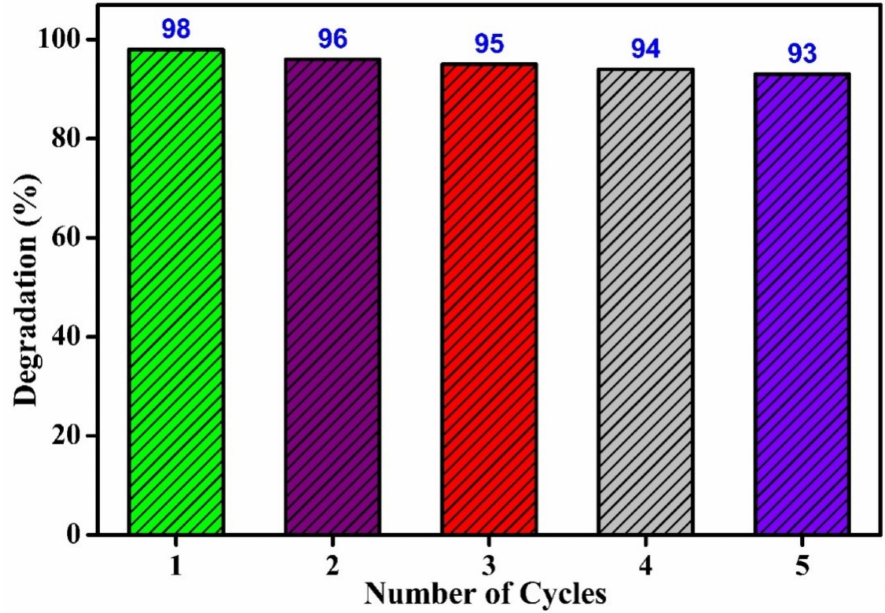
Figure 7. Reusability of TSU80 catalyst for degradation of MO dye under UV light irradiation.